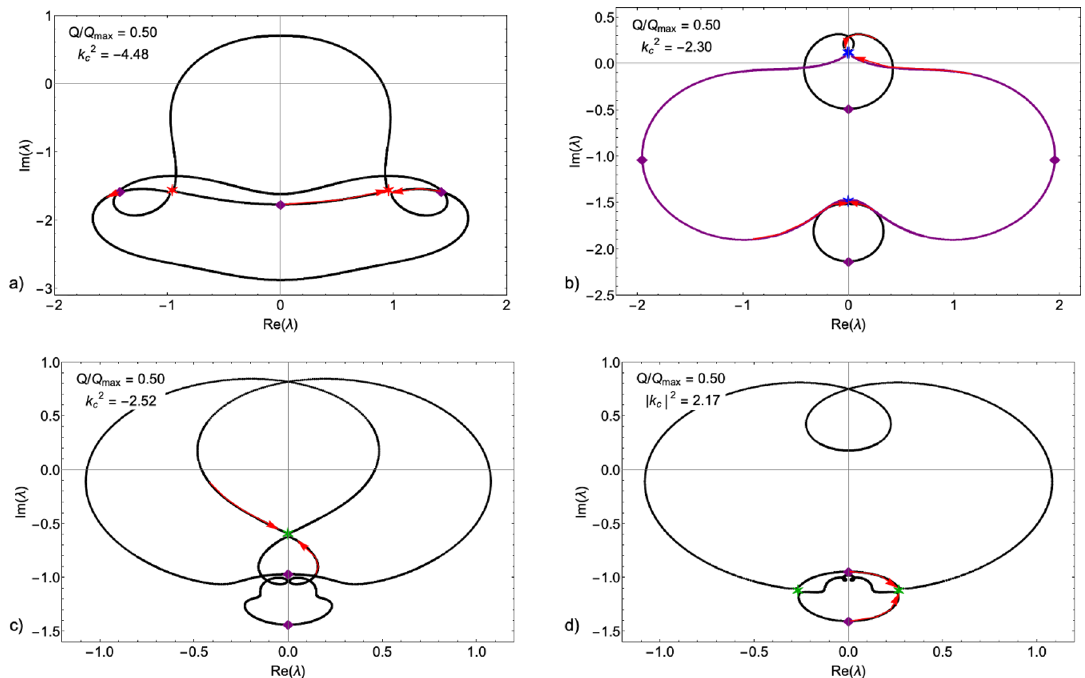
Figure 2 . Quasinormal modes in the shear channel in d = 3 at (cid:12)xed j k j 2 , illustrating the quali- tatively di(cid:11)erent types of collisions. Purple diamonds indicate the QNMs at real momentum and stars indicate the collisions, with the color matching the color in (cid:12)gure 1. The red arrows indicate the movement of the modes as the phase approaches the critical